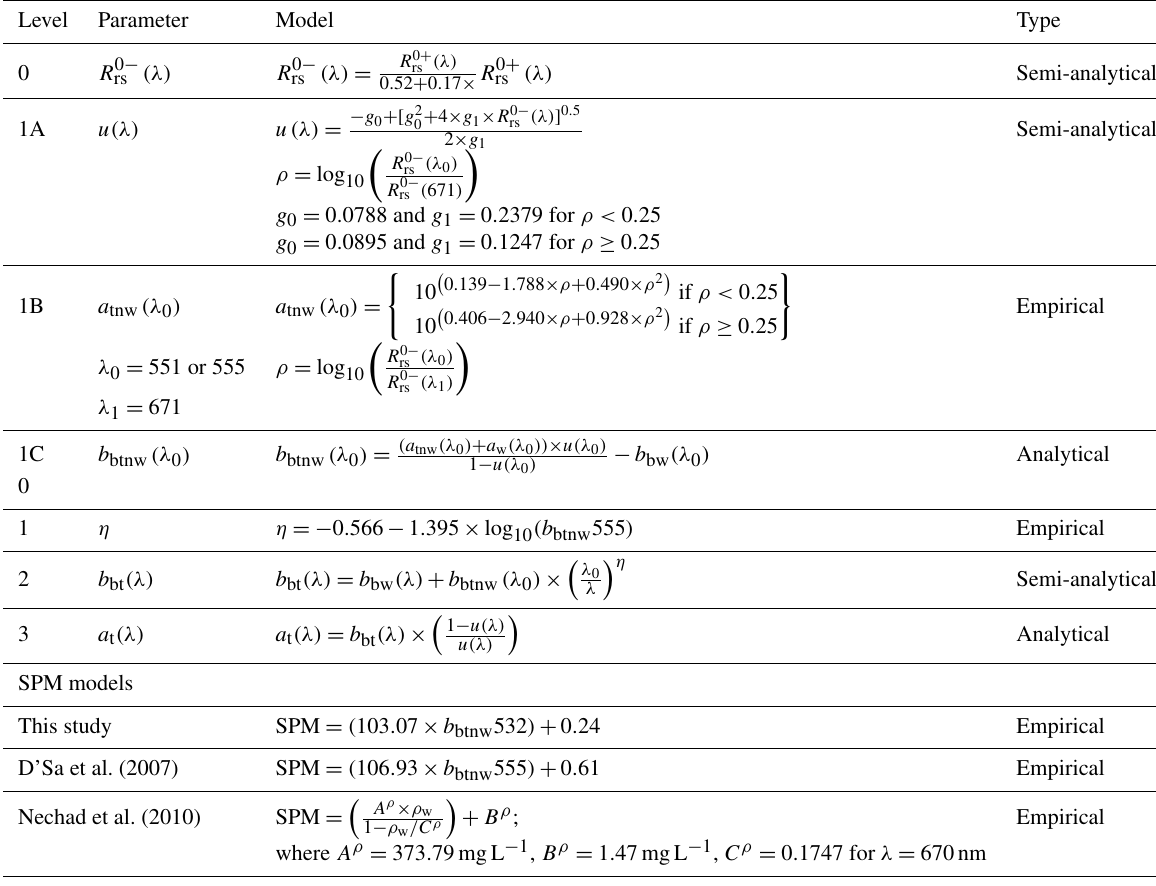
Table 2. Processing steps of QAA-V for obtaining total absorption ( a t ) and backscattering coefficients ( b bt ). Levels 0 and 1C were adopted from Lee et al. (2002), whereas 1A and 1B were modified in this study ∗ . Level 1C1 is adopted from D’Sa et al.